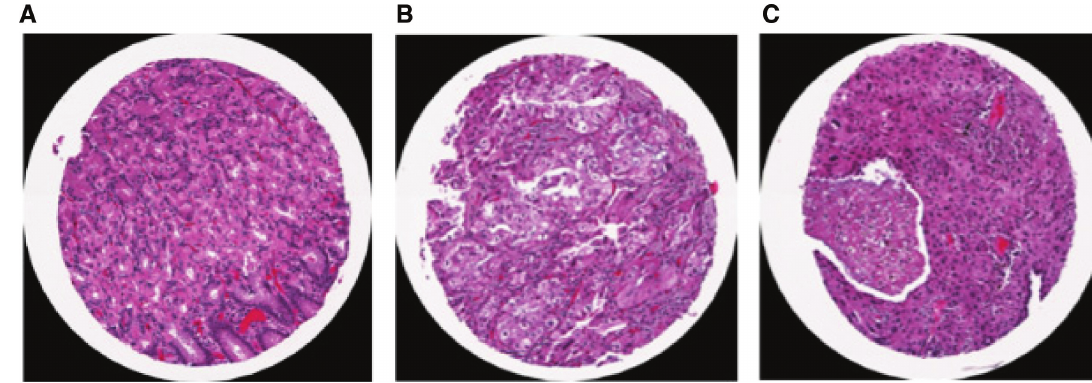
Figure 2: Sample images collected from the TMAD database.